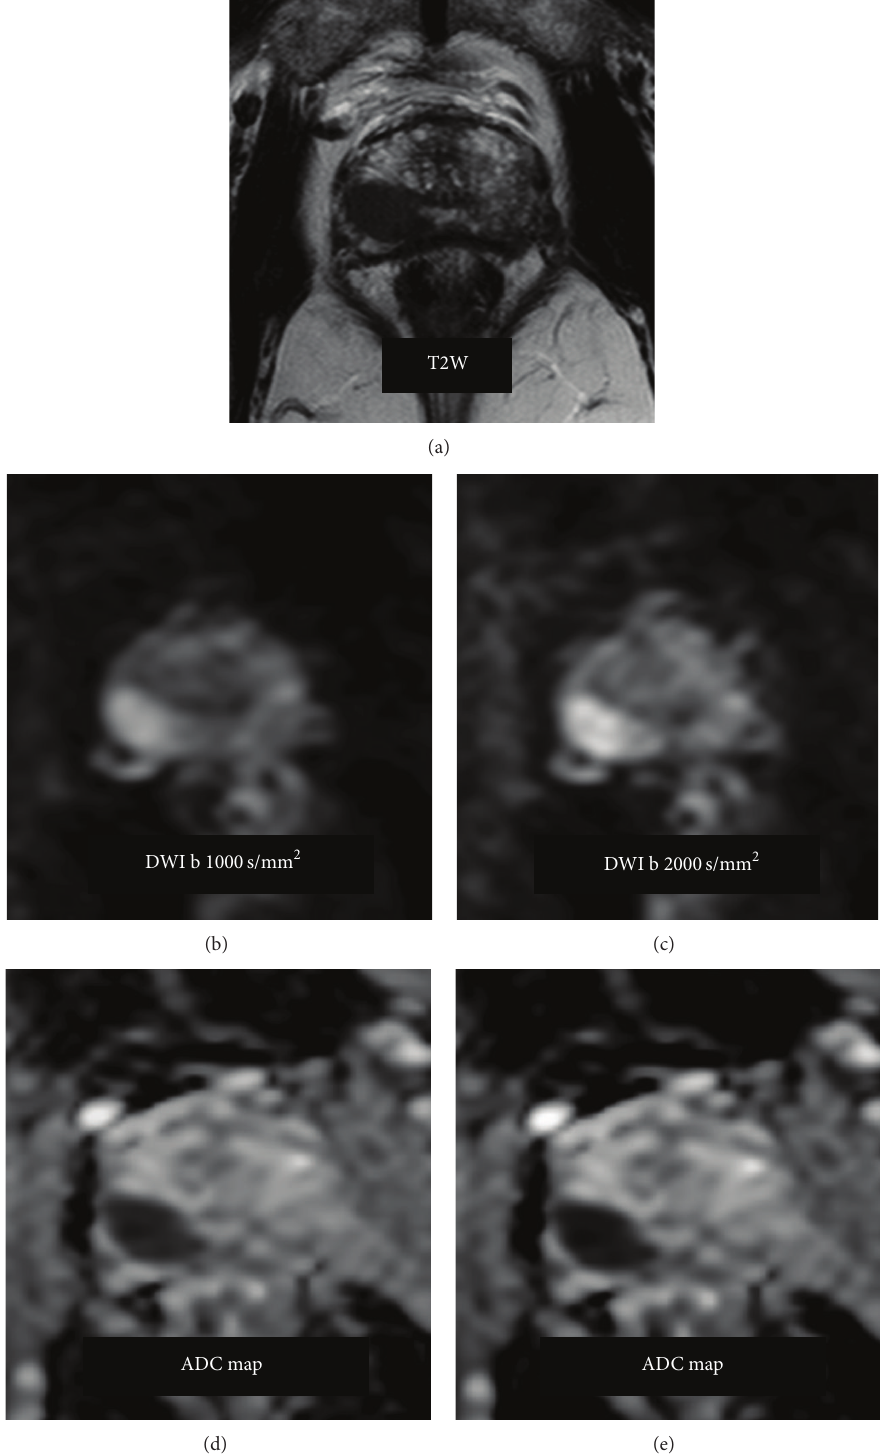
Figure 3: A 74-year-old man with prostate cancer Gleason 4 + 4. (a) T2-weighted image shows a hypointense focal area on right midgland in the peripheral zone. ((b) and (c)) DWI b -value of 1000s/mm 2 and 𝑏 -value of 2000 s/mm 2 show a focal increased signal in the right peripheral zone easily distinguishable from the surrounding benign tissue. ((d) and (e)) ADC maps obtained with 𝑏 -values of 0–1000s/mm 2 (d) and 0–2000 s/mm 2 (e) show the tumor as a focal area of decreased signal on the right midgland of the peripheral